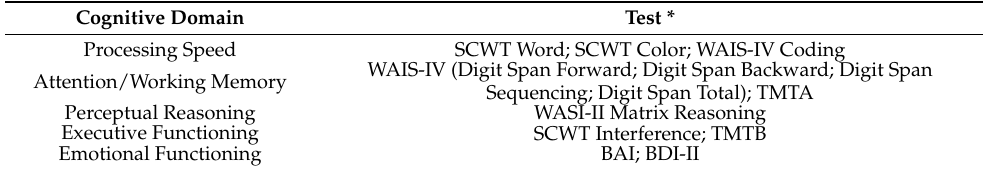
* Abbreviations in Table: BAI = Beck Anxiety Inventory; BDI-II = Beck Depression Inventory, Second Edition; SCWT = Stroop Color and Word Test; TMTA = Trail Making Test A; TMTB = Trail Making Test B; WAIS = Wechsler Adult Intelligence Scale, Fourth Edition; WASI-II = Wechsler Abbreviated Scale of Intelligence, Second Edition. Processing speed was measured using the Stroop Color and Word Tests (SCWT) Word and Color Scores, as well as the Wechsler Adult Intelligence Scale 4th edition (WAIS-IV) IV Digit Span Forward (DSF), Backward (DSB), Sequencing (DSS), and Total (DST),